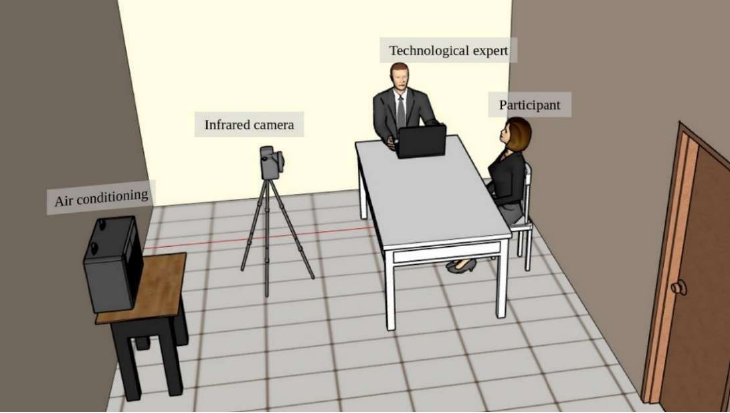
Figure 1. Conditioned